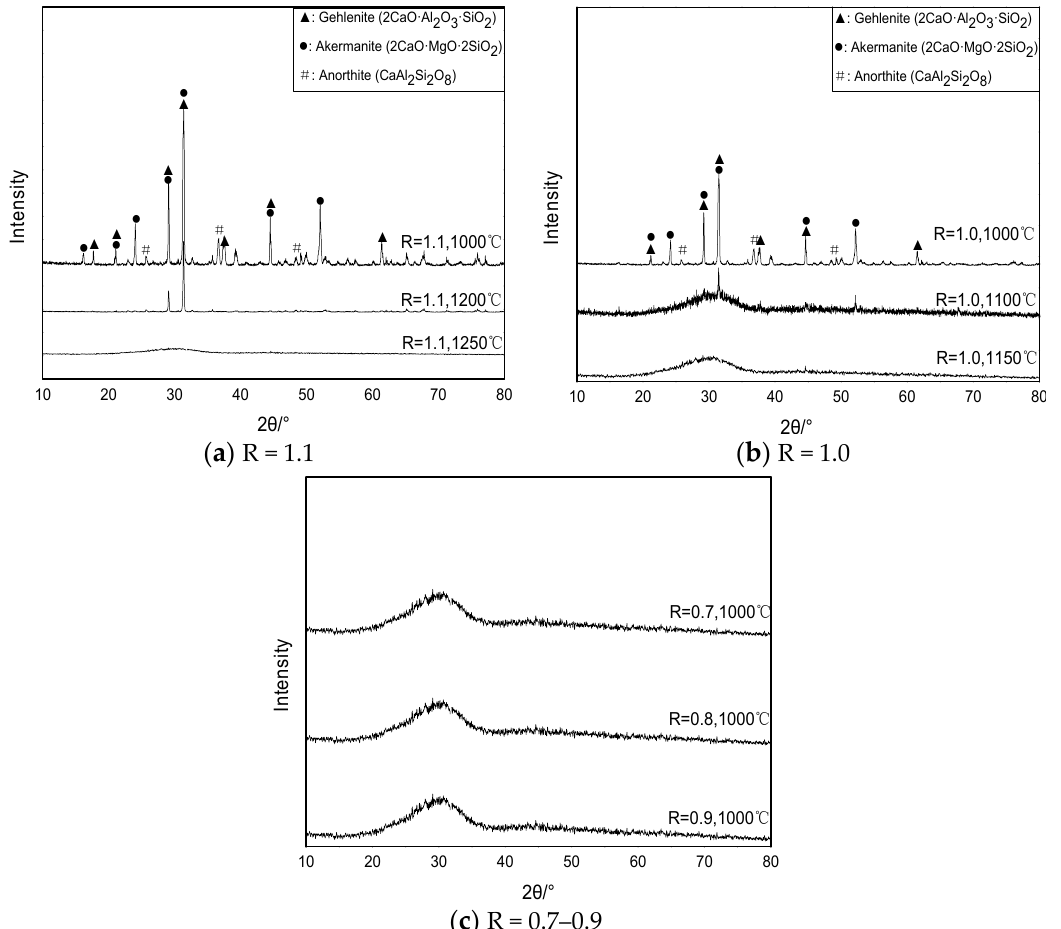
Figure 4. XRD analysis of BFS with different basicities.